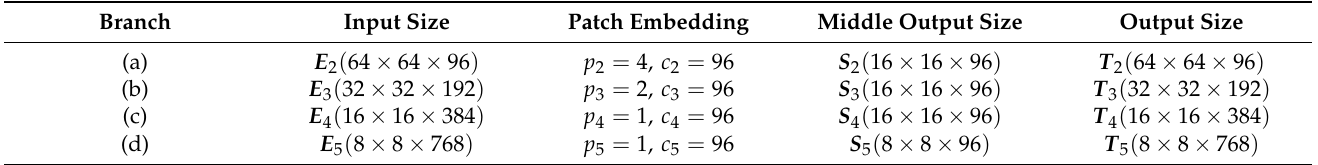
Table 1. The parameter settings in the self-supervised block.